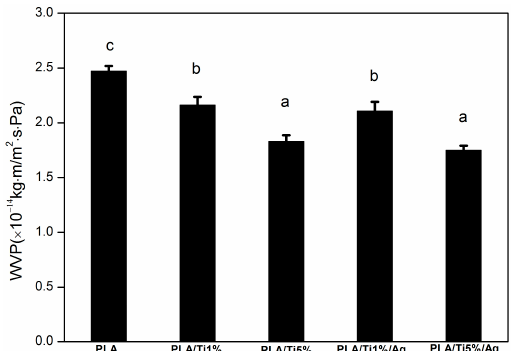
Figure 1. WVP analysis of pure PLA and PLA nano-blend films. Values followed by different superscript letters (a–c) in the same column were significantly different ( p < 0.05), where a is the lowest value.